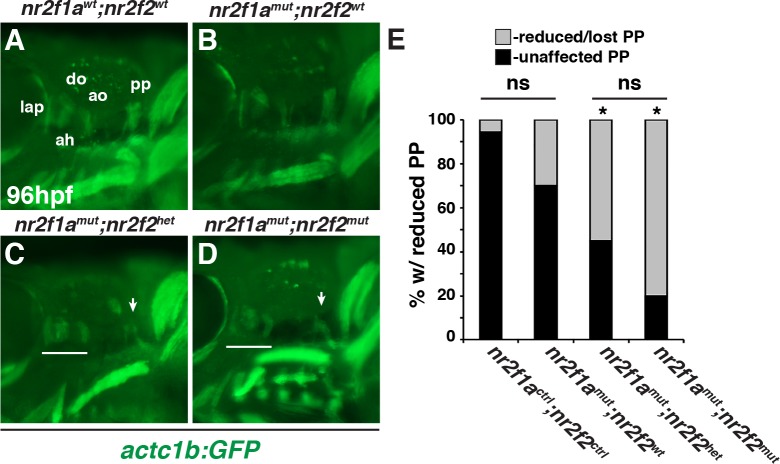
Nr2f1a; nr2f2 mutants have deficiencies in their posterior PMs.(A-D) PMs in nr2f1awt; nr2f2wt, nr2f1amut; nr2f2wt, nr2f1amut; nr2f2het, and nr2f1amut; nr2f2mut embryos with the actc1b:GFP transgene at 96 hpf. IHC was performed for GFP. Views are lateral with anterior to the left and dorsal up. Arrows in C and D indicate largely absent protractor pectoralis (pp). Brackets in C and D indicate 1st and 2nd arch PMs. ah–adductor hyoideus, ao–adductor operculi, do–dilator operculi, lap–levator arcus palitini. Muscle nomenclature used is from [55]. (E) Percentage of nr2f1actrl; nr2f2ctrl (n = 18), nr2f1amut; nr2f2wt (n = 10), nr2f1amut; nr2f2het (n = 29), and nr2f1amut;nr2f2mut (n = 15) embryos with loss or malformed pp muscles at 96 hpf.